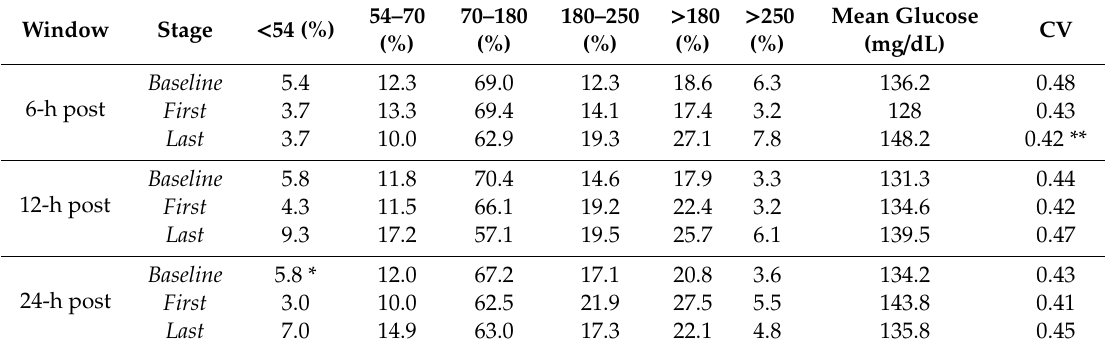
Table 2. Average cohort isCGM values from FSL for di ff erent observation windows after the end of exercise interventions.